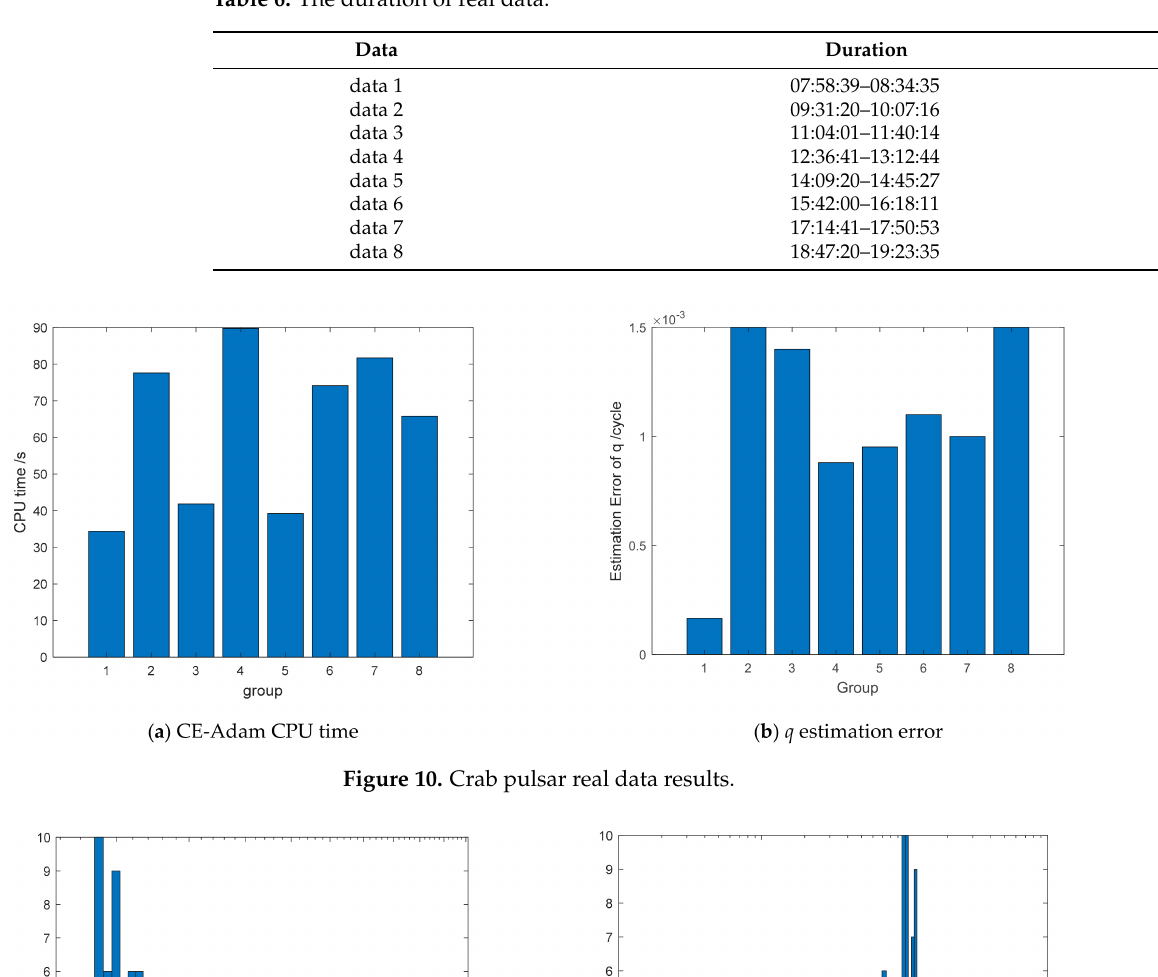
Table 6. The duration of real data.